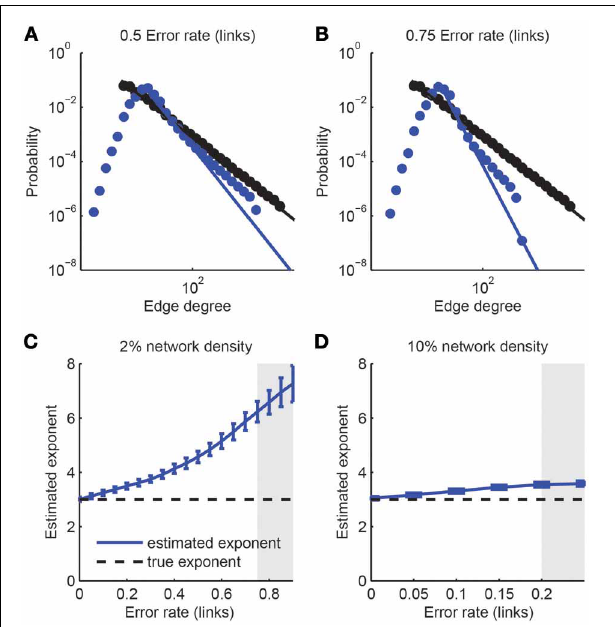
FIGURE 7 | Detection of scale-free graphs upon imperfect connectivity reconstruction. (A,B) Degree distributions of networks after simulated reconstructions. The degree distribution of the original network (1000 neurons, 4% link density) follows a power law p ( x ) ∼ x − 3 above a minimal degree (black dots and line). Reconstructed networks (blue dots) were obtained with varying error rate in the link reconstruction, ranging from 0.50 (left) to 0.75 (right). In all cases the best-fitting power law to the tail of the degree distribution is indicated (blue line). (C,D) Estimated power-law coefficients, obtained from power-law fits to the tails of estimated degree distribution, as a function of error rate in link reconstruction for different network densities. Error bars: standard deviation over 1000 simulations. The coefficient of the original network is indicated by the horizontal dashed line. A goodness-of-fit test was applied to each fit. If more than 50% of the p -values were below 0.05, the region is grayed out, indicating that the resulting degree distributions were generally inconsistent with the power-law